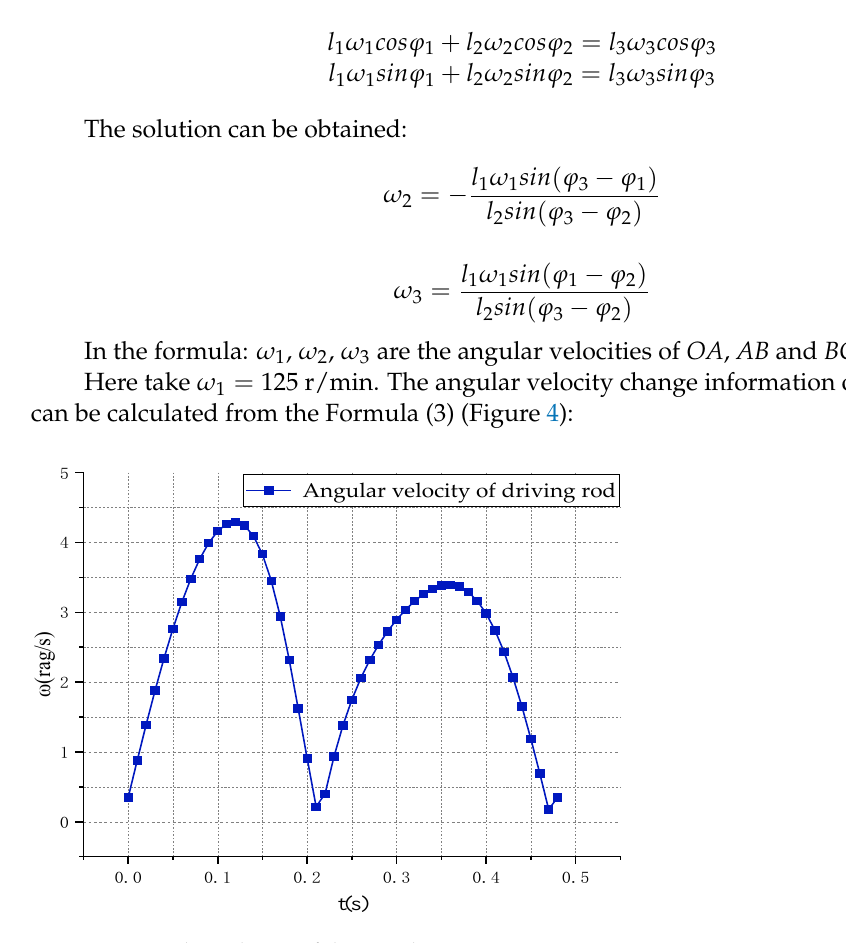
Figure 3. Position of drive rod.